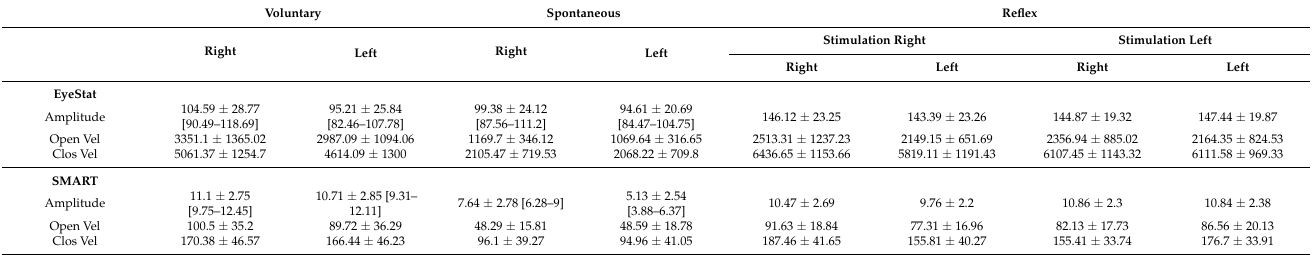
Table 3. Kinetic parameters of the voluntary, spontaneous, and reflex blinking measures with the EyeStat and SMART systems. Open Vel: velocity of the opening phase; Clos Vel: velocity of the closing phase. Amplitude is expressed in pixels (px) when measured with EyeStat and in millimeters (mm) when measured with the SMART system. Absolute blinking velocity values are expressed in px/s when measured with EyeStat and in mm/s when measured with SMART. Data are indicated by mean ± standard error of the mean. Confidence intervals of 95% for the amplitude means are reported indicated in square brackets.